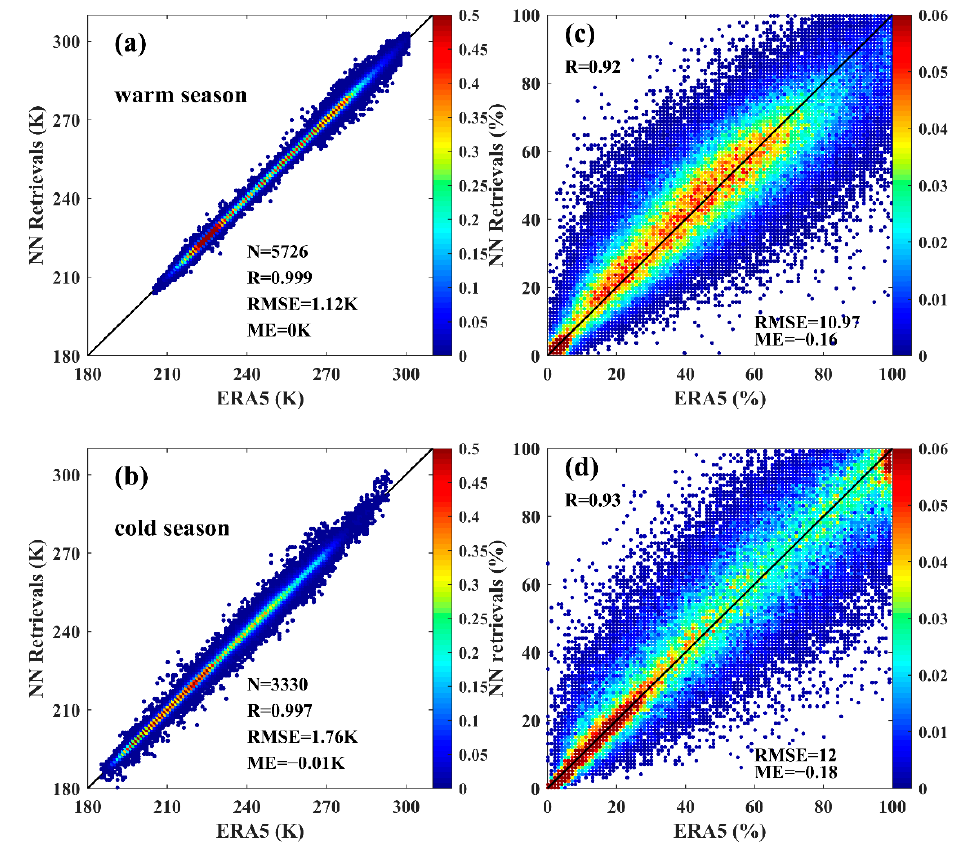
Figure 5. Density scatter diagram of retrieval results on land; ( a , b )The relationship between the temperature retrievals of all 42 atmospheric layers up to 1 hPa and ERA5. ( c , d ) The relationship between the RH retrievals of all the 25 atmospheric layers up to 100 hPa and ERA5 (N represents the number of validation samples; R represents the correlation coefficient).